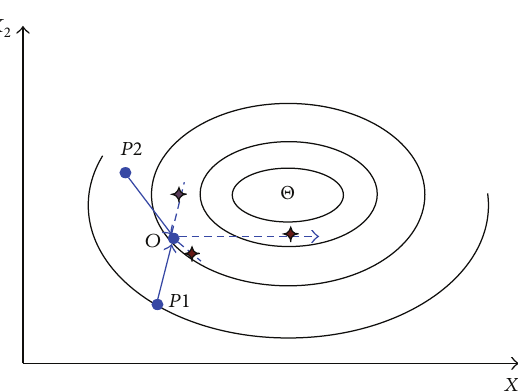
Figure 1: A contour plot of a 2-dimensional problem with the three directions indicated: Parent 1 direction is from 𝑃1 to 𝑂 ; Parent 2 direction is from 𝑃2 to 𝑂 ; the common direction is a horizontal dotted line, starting at 𝑂 towards the positive values on the 𝑋 1 axis. The three “stars” represent the three points stopped on the three paths with no further